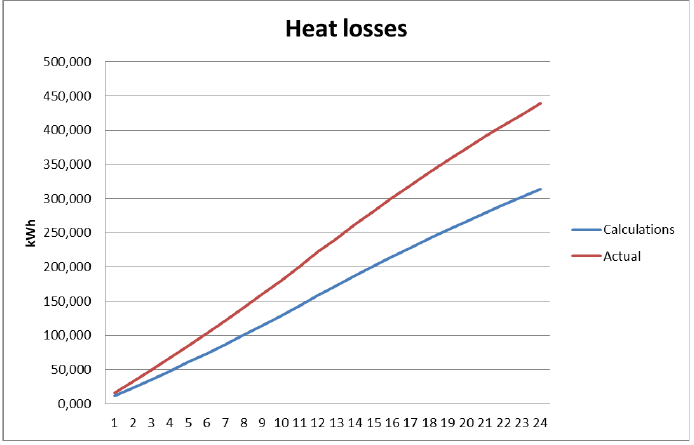
Figure 10. Calculated heat losses and real ones with implemented correction